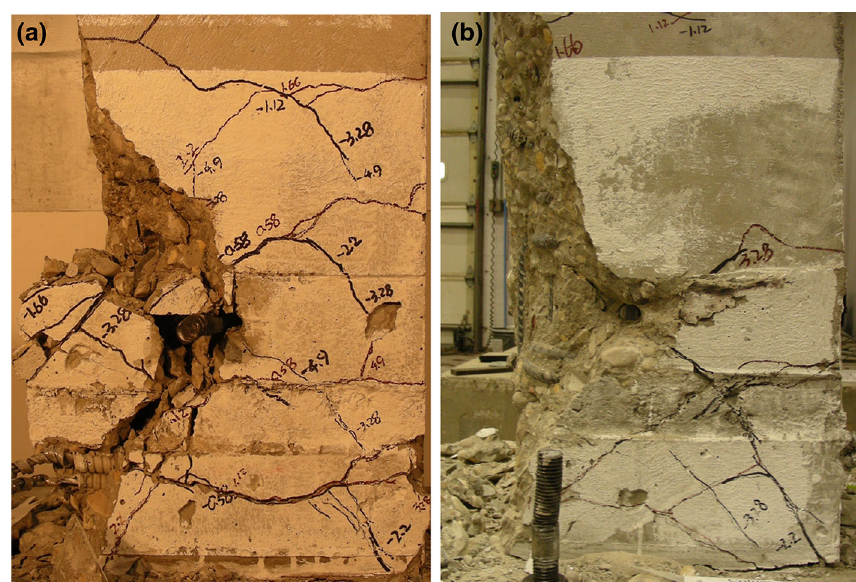
Fig. 10 Surface cracks near test anchor in the plastic hinge zone. a Specimen S1 and b specimen curve in Fig. 9b. The actuator displacement contained the lateral deformation of the column at 8 in. above the base.